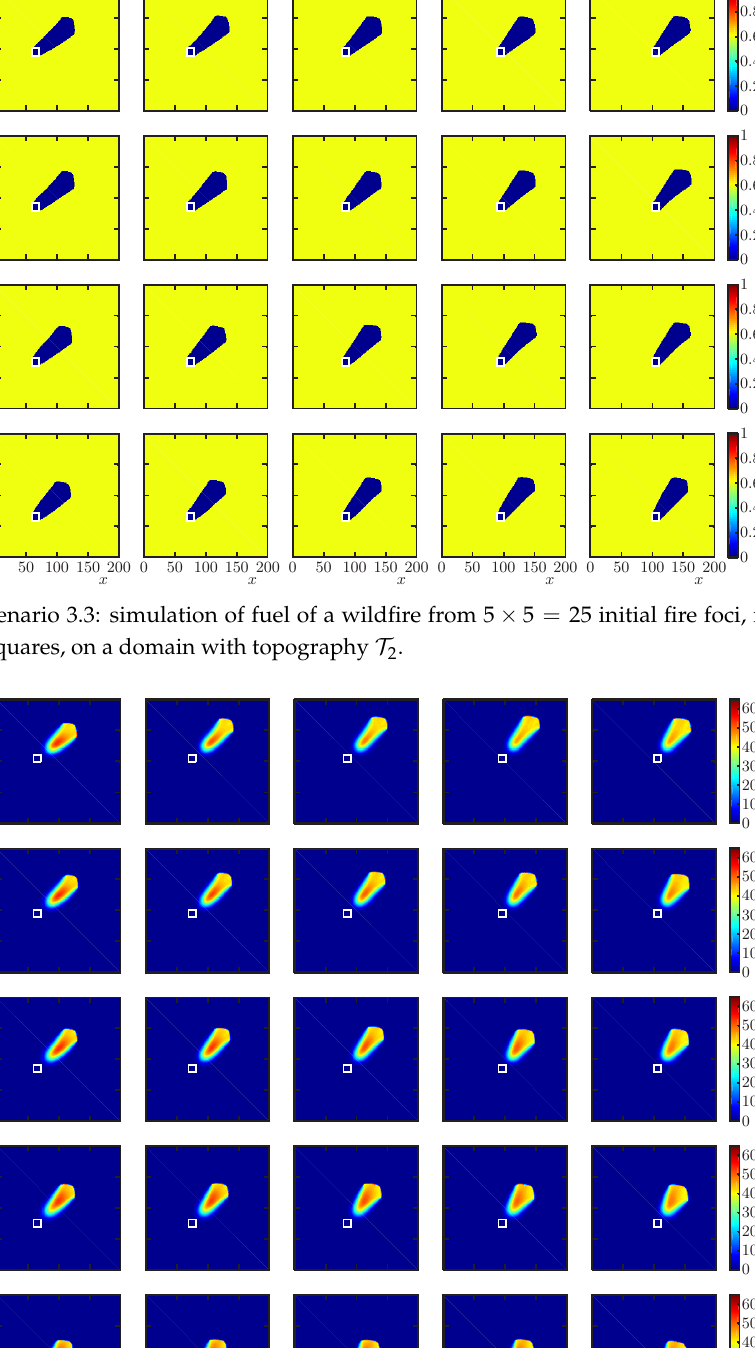
Figure 13. Scenario 3.4: simulation of temperature of a wildfire from 5 marked by small white squares, on a domain with topography